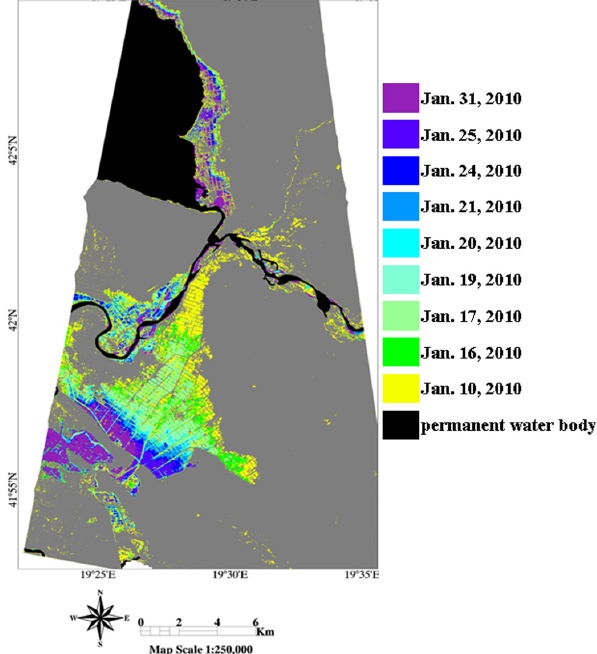
Fig. 6. Multi-temporal map showing the time evolution of the Shkod¨er flood. It has been produced by applying our algorithm to nine COSMO-SkyMed images whose acquisition dates are reported in the legend. White: no data; gray: